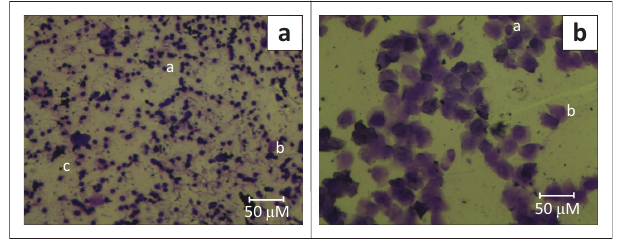
FIGURE 1: Representative × 100 images of gentian violet-stained exfoliative vaginal cytology from animals used in this study corresponding to: (a) pro- oestrus phase with mainly nucleated cornified epithelial cells undergoing cornification (a), few cornified epithelial cells (b), and few lymphocytes (c). (b) Oestrus phase with mainly anucleated cornified epithelial cells (b), sparsely- nucleated epithelial cells (b)?.